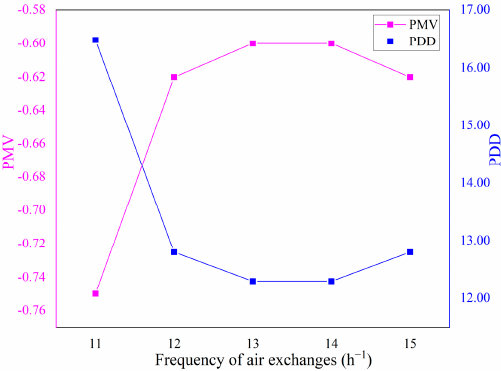
Figure 15. Comfort evaluation.